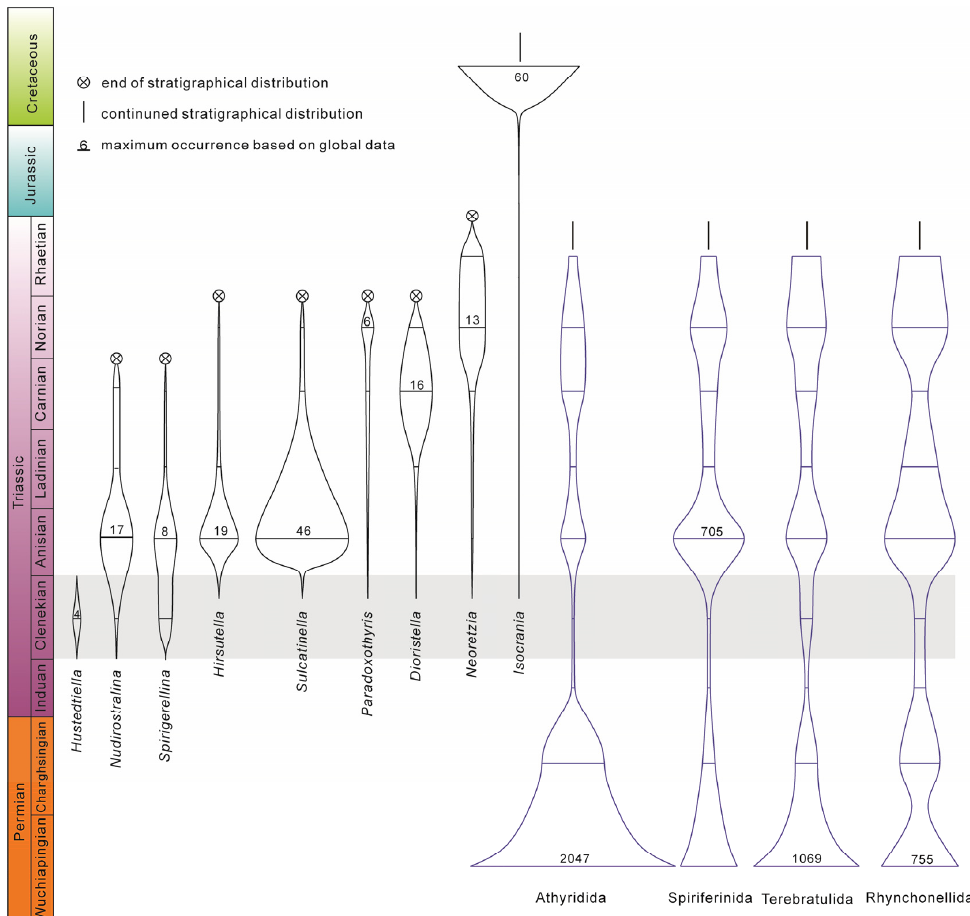
Figure 11. Stratigraphic ranges and occurrences of the Datuguan brachiopod genera (shown by black lines) and four brachiopod orders (shown by purple lines). Numbers above lines represent the highest occurrence frequency of genera.